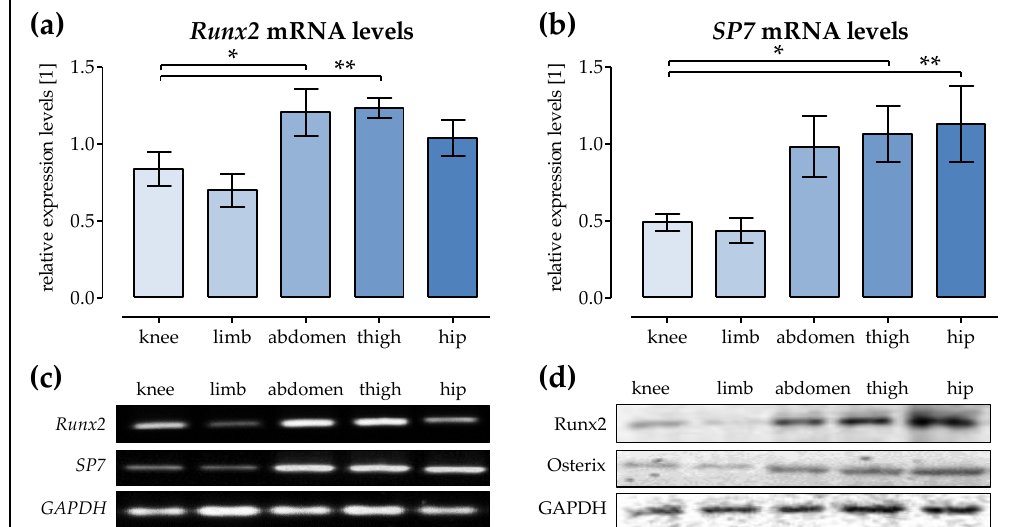
Figure 4. The expression of Runx2 and SP7 in Ad-MSCs varies depending on the donor site. Ad-MSCs derived from adipose tissue of the knee, limb, abdomen, thigh, and hip ( N = 4 each) were osteogenically differentiated for 14 days. The relative expression levels of ( a ) Runx2 and ( b ) SP7 were determined by semi-quantitative RT-PCR. The PCR products were loaded twice ( n = 2) to minimize the loading errors. The signal intensities were quantified with the help of the ImageJ software; ( c ) Representative images for the RT-PCR products from the pooled samples; ( d ) Representative images for the Western blot signals obtained from the pooled samples; * p < 0.05 and ** p < 0.01 as indicated.